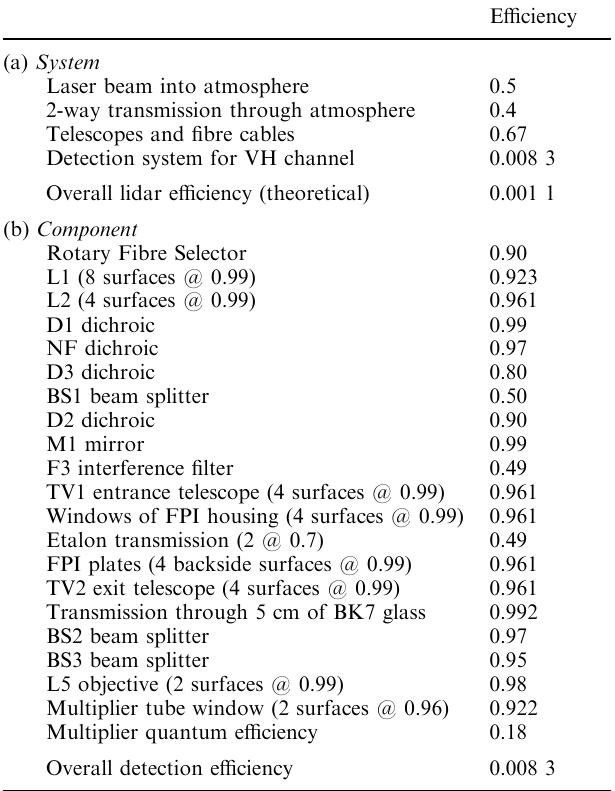
Table 4. E(cid:129)ciencies for photon throughput: (a) system e(cid:129)ciencies; (b) component e(cid:129)ciencies of detection system for the 532 nm VH